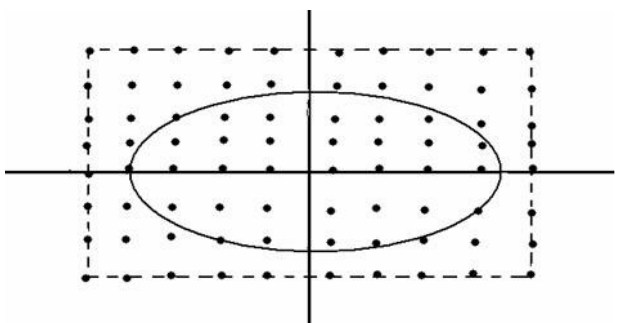
FIG. 5. A square or rectangular grid in the x , y plane for a fixed z value on the three-dimensional grid. Values at data points near the ellipse are to be interpolated onto the